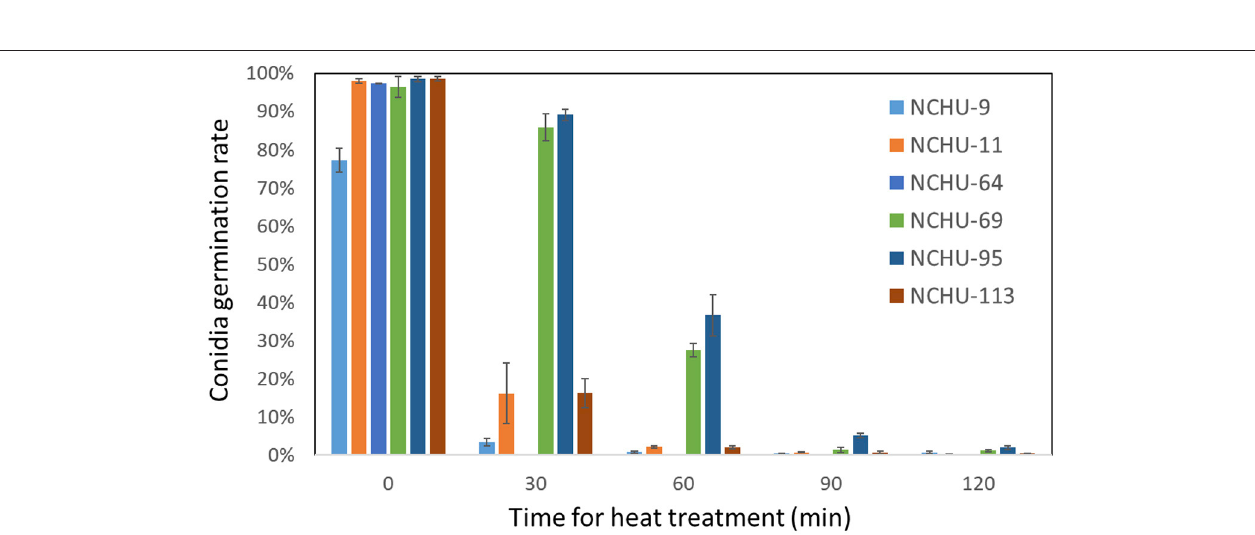
FIGURE 7 | Thermotolerance of six fungal isolates under different durations of 45 ◦ C heat treatment. The experiments were replicated three times for each fungal isolate.